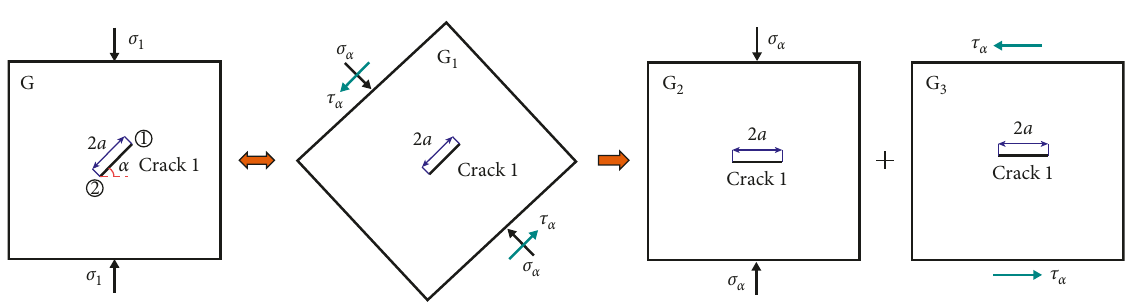
Figure 7: Equivalent sketch of stress state (G) of rock mass under uniaxial tension.